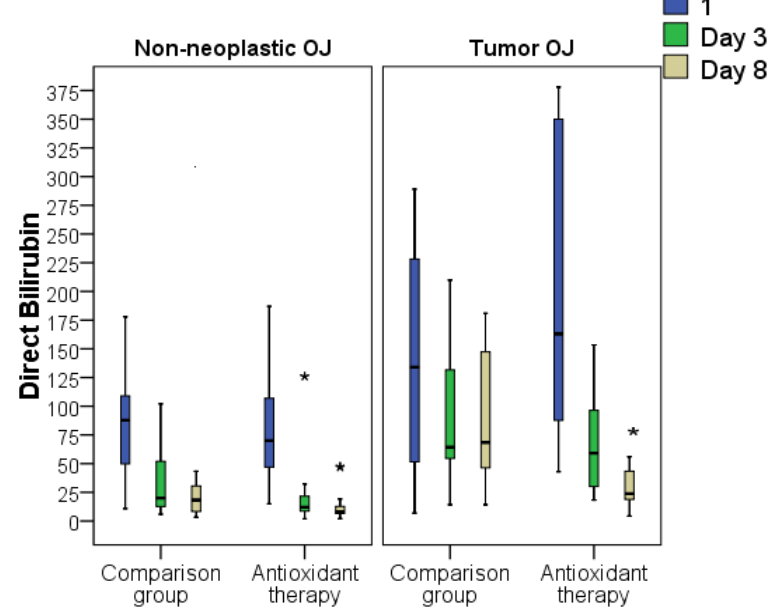
Figure 8. Dynamics of the direct bilirubin indicator in tumor and non-tumor jaundice in patients who received and did not receive antioxidant therapy (* difference between the comparison groups and AOT at p < 0.05). Abbreviations: OJ, obstructive jaundice.